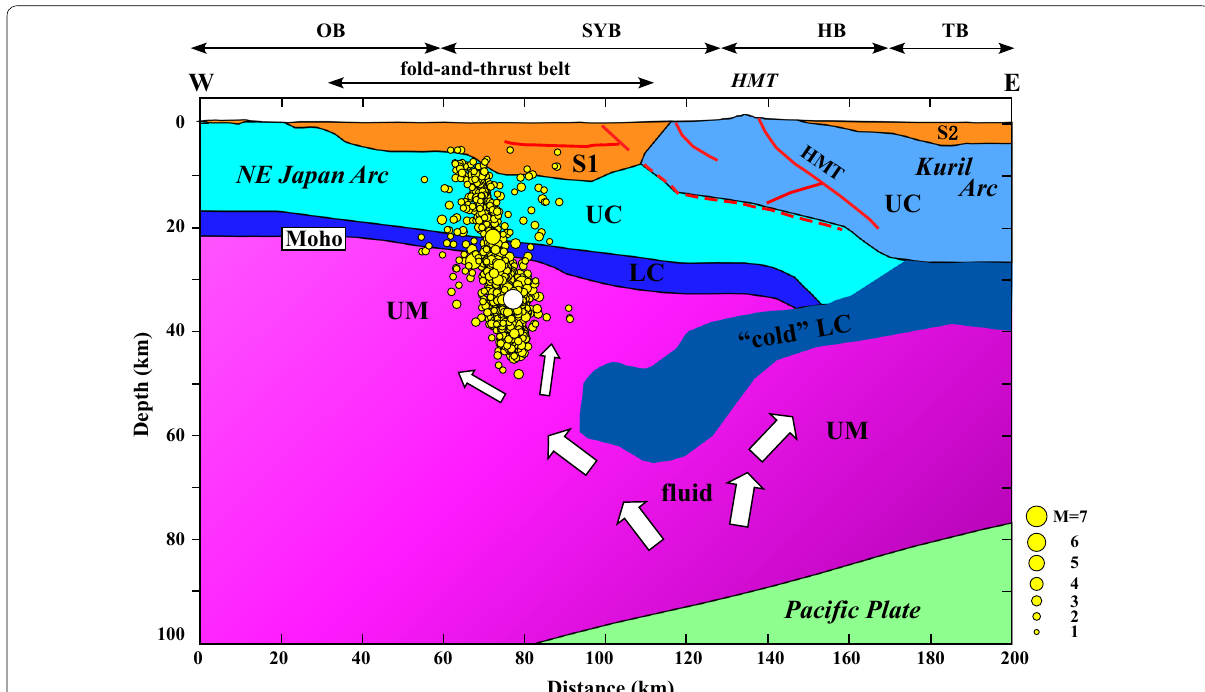
Fig. 12 Schematic structure model in and around the source region of the Hokkaido Eastern Iburi earthquake. All of the relocated aftershocks are plotted by yellow circles. A white circle is a location of the main shock. Delaminated lower crust is shown in dark blue. White arrows indicate of migration of fluids released from the subducted Pacific Plate by dehydration. S1: Sedimentary package in the fold-and-thrust belt; S2: Sedimentary layers in HB and TB; UC: Upper crust; LC: Lower crust; HMT: Hidaka Main